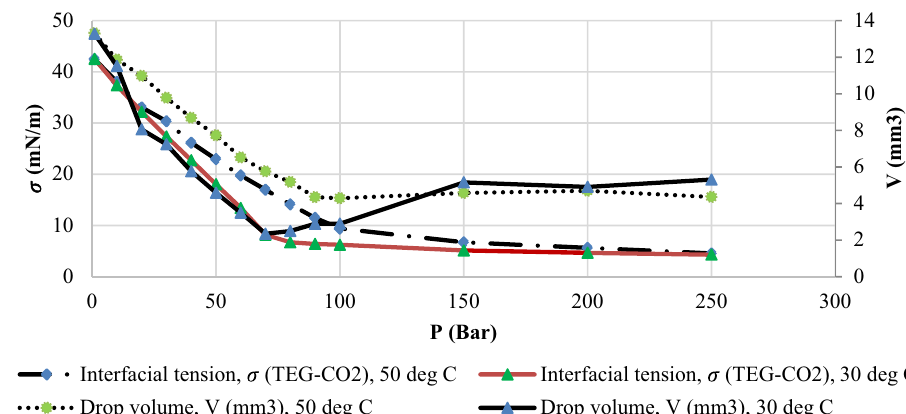
Fig. 6 Static interfacial tension of tri-ethylene glycol (TEG) in CO 2 as a function of pressure at 30 °C and 50 °C. The figure also shows the drop volume of TEG–CO 2